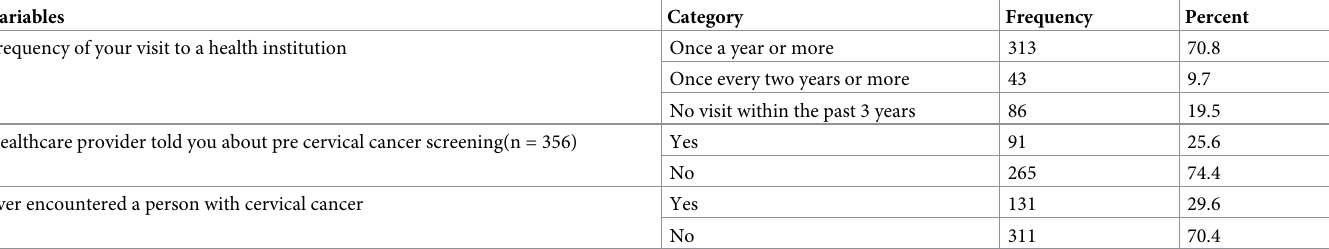
Table 3. Information and invitation about cervical cancer and its screening practice by health care providers among females (15–49 years) in Durame town, SNNPR, Ethiopia, 2020 (n = 442).